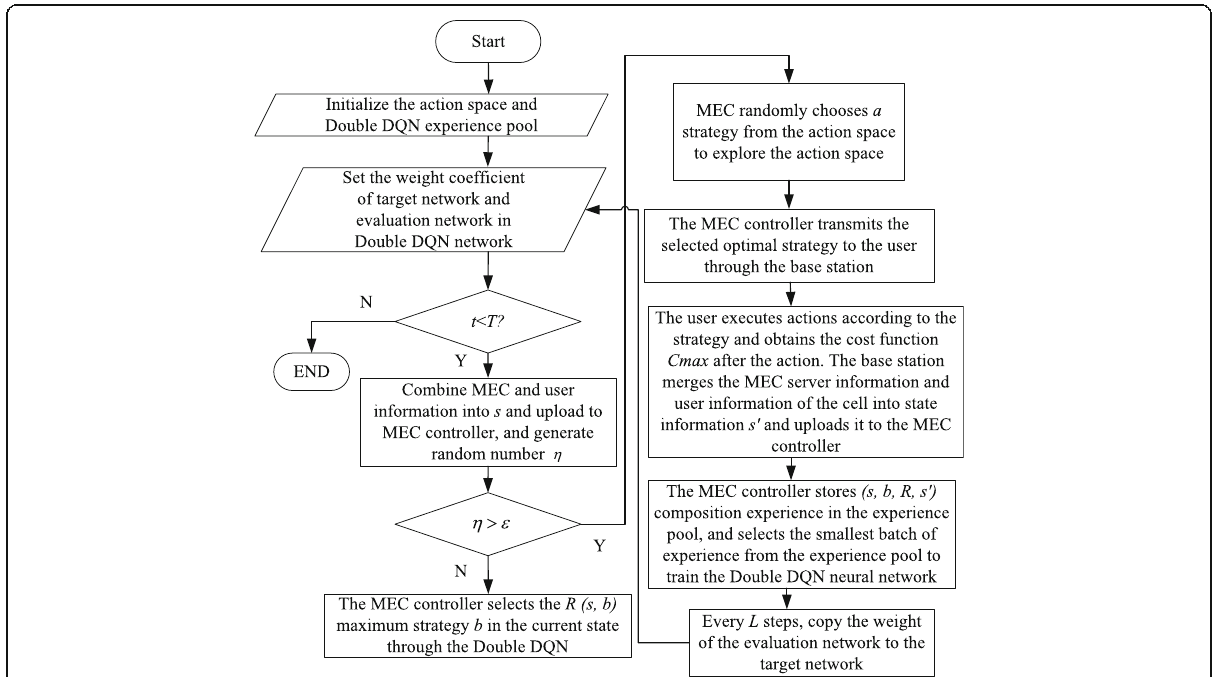
Fig. 5 Collaborative scheduling strategy flow of computing resources based on Double DQN